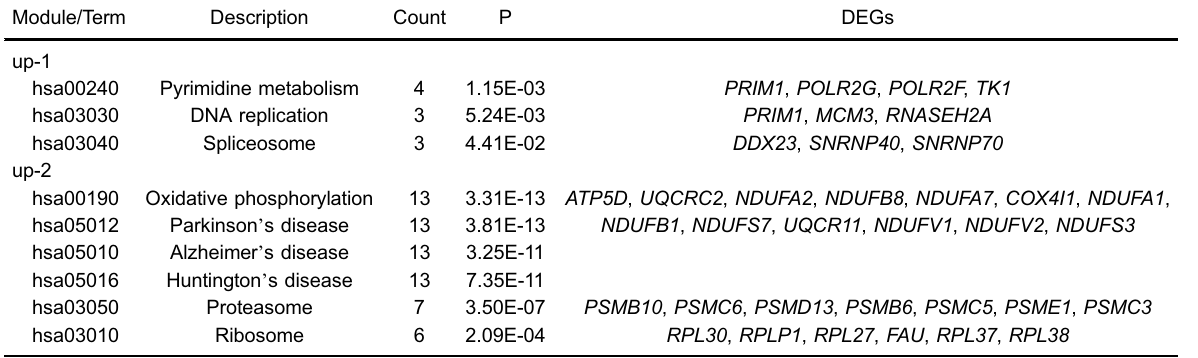
Table 3. Enriched KEGG pathways for genes in upregulated modules with a higher enrichment score.